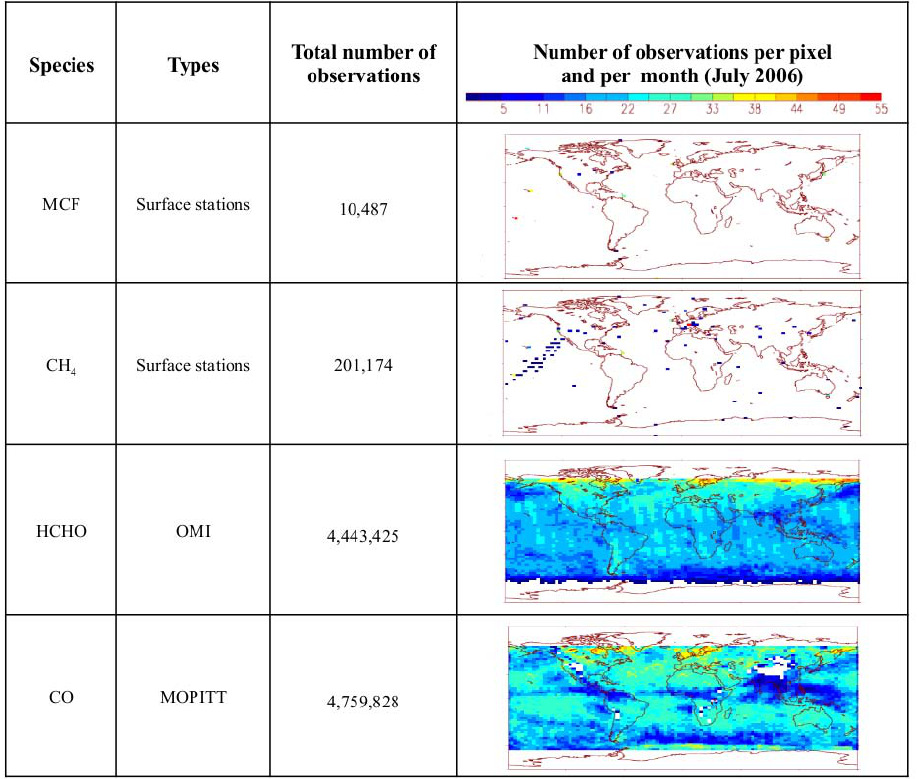
Fig. 2. Summary of the observations used in the inversion: total number of observations over the 2005–2010 time period and typical distri- butions of these observations on the right for July